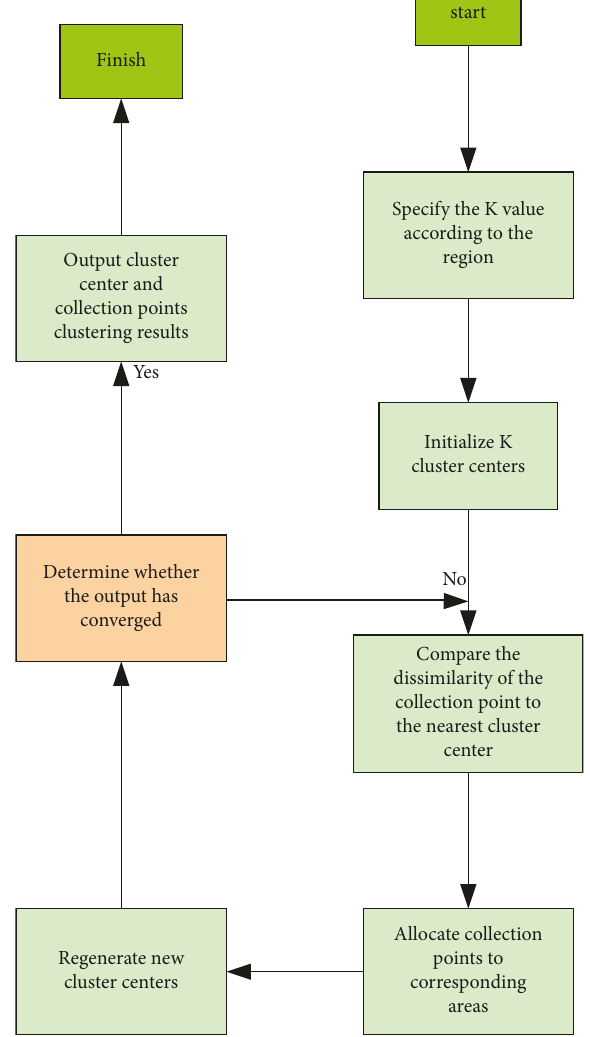
Figure 4: Flowchart of the K-means clustering